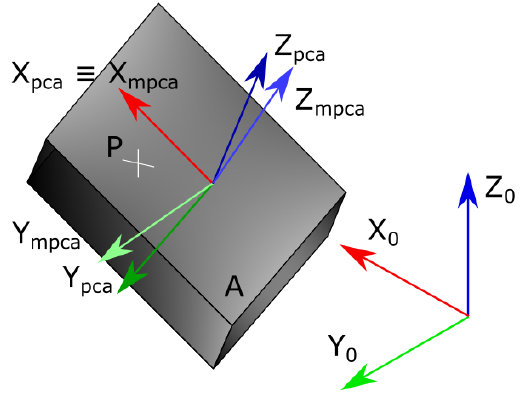
Figure 4. MPCA: X 0 , Y 0, Z 0 are the world coordinates; X pca , Y pca , Z pca , are the PCA eigenvectors Figure 4. MPCA: 𝑿 𝟎 ,𝒀 𝟎, 𝒁 𝟎 are the world coordinates; 𝑿 𝒑𝒄𝒂 ,𝒀 𝒑𝒄𝒂, 𝒁 𝒑𝒄𝒂 , are the PCA eigenvectors ap- applied in A; X mpca , Y mpca , Z mpca are the MPCA eigenvectors applied in plied in A; 𝑿 𝒎𝒑𝒄𝒂 , 𝒀 𝒎𝒑𝒄𝒂, 𝒁 𝒎𝒑𝒄𝒂 are the MPCA eigenvectors applied in A.